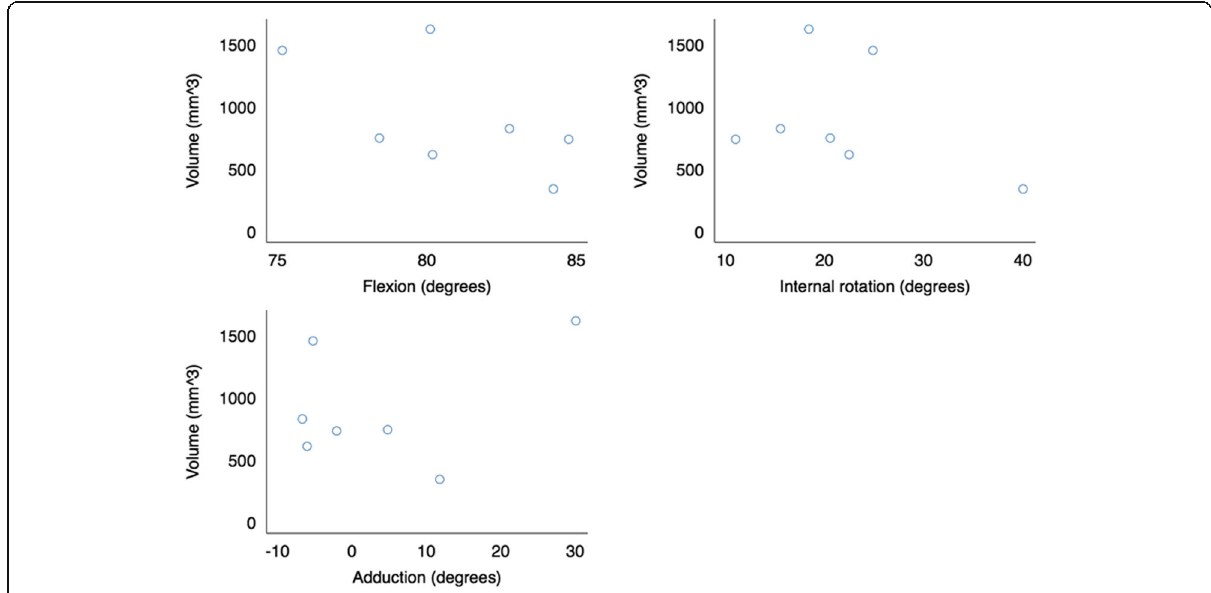
Fig. 7 Scatter plots of the volume of removed bone with respect to the postoperative flexion, internal rotation and